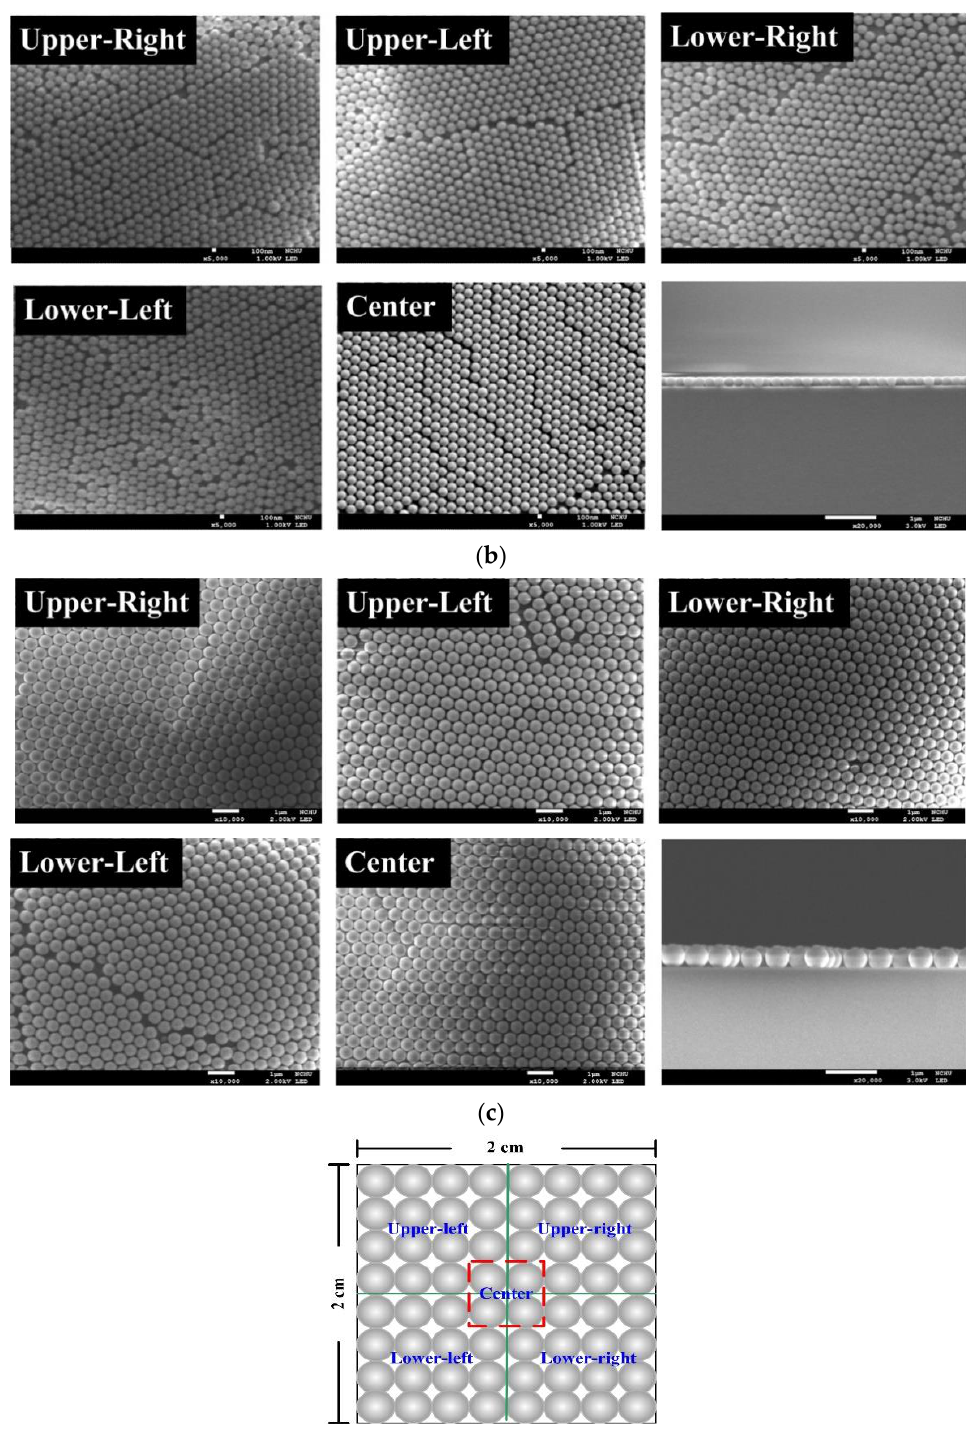
Figure 3. Plan-view and cross-section SEM images of PS NS array with diameters of ( a ) 100, ( b ) 200, and ( c ) 500 nm and ( d ) SEM-measured region on glass substrate for SEM images of ( a – c ). The light escape cone of an InGaN/GaN LED is limited by the high refractive index contrast between GaN and air; as a result, it leads to a low LEE. Let k be the wave vector of the escape cone; then, [46]